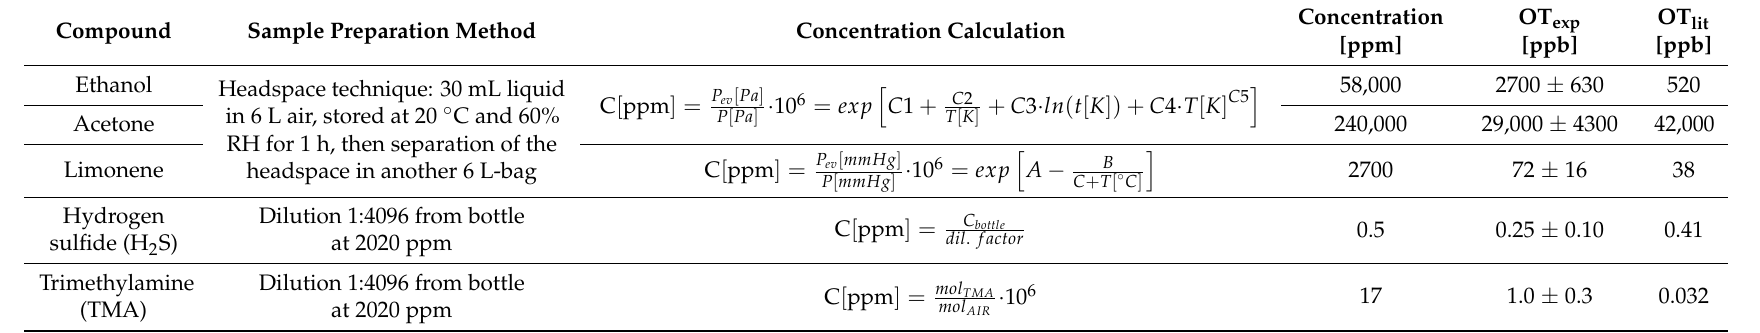
Table 2. Concentration of the target compounds in the test samples and odor detection